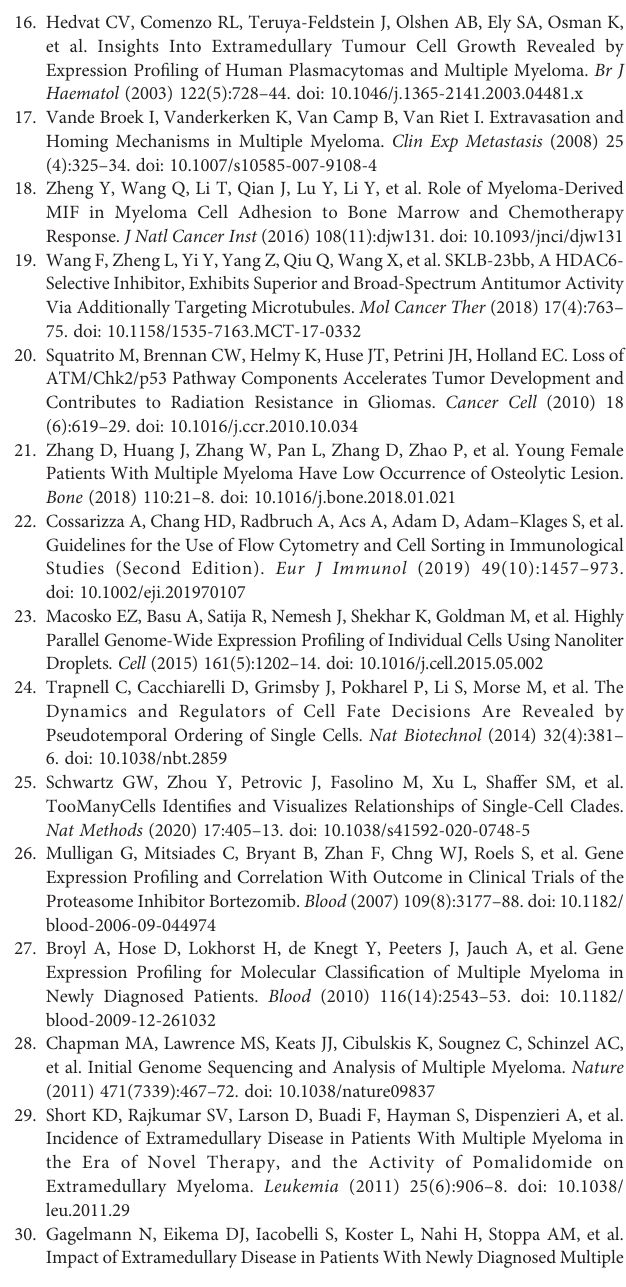
three types of grafts: All of them were positive for CD138; MIF was homogenously over-expressed in both ARD cells and patient-derived primary BM MM cells, and totally absent in MIF-/-ARD cells (B) . Intravenous injection of human MM cells led to both intra- and extra-medullary lesions in immunode fi cient mice. More serious EMM lesions were detected in the MIF-/- ARD group. The representative in vivo bioluminescent imagings were taken at two weeks after inoculation (C) . Supplementary Figure 5 | Supplementary data of the sc-RNAseq. Parallel fl ow cytometry analysis con fi rmed the differential expression of MIF protein in CD138+ cells subjected to sc-RNAseq (A) . Co-expression of DDT, POLR2F and MIF in patient MM cells from BM was validated in three microarray datasets: GSE26760, GSE19784, and GSE9782, by gene set enrichment analysis (GSEA) with Pearson correlation (R2, R-square) (B)